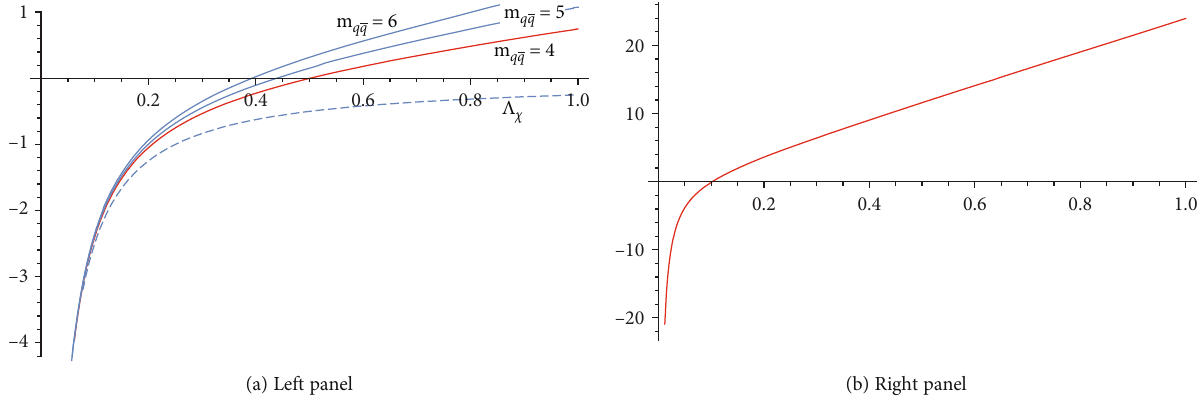
ð r , m Þ against ( r , m s q (cid:1) q